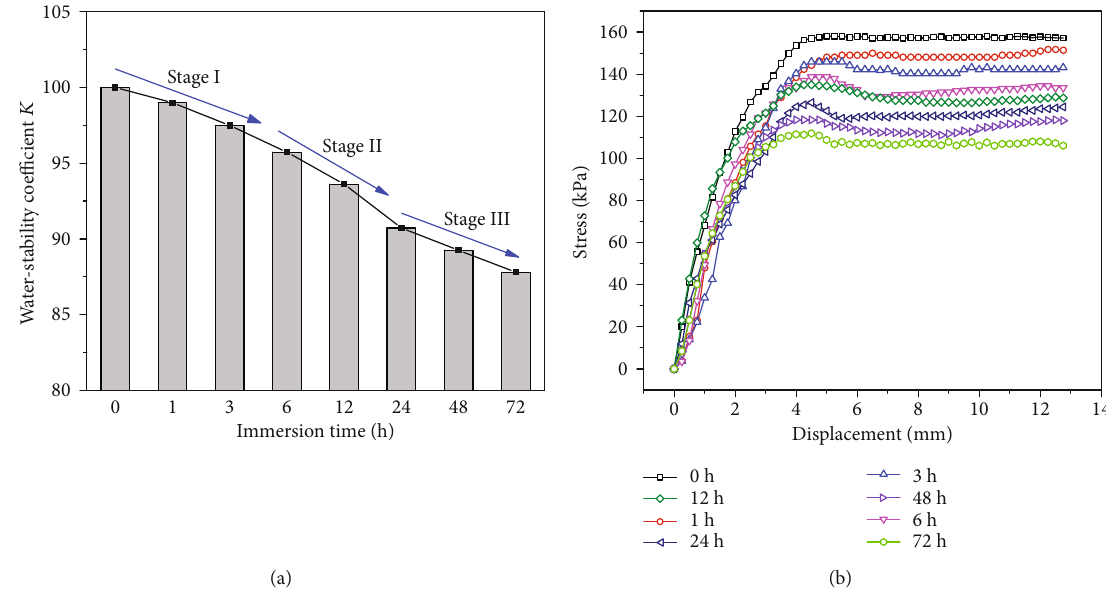
Figure 5: (a) The e ff ect of immersion time on the water-stability coe ffi cient; (b) the typical direct shear stress-displacement